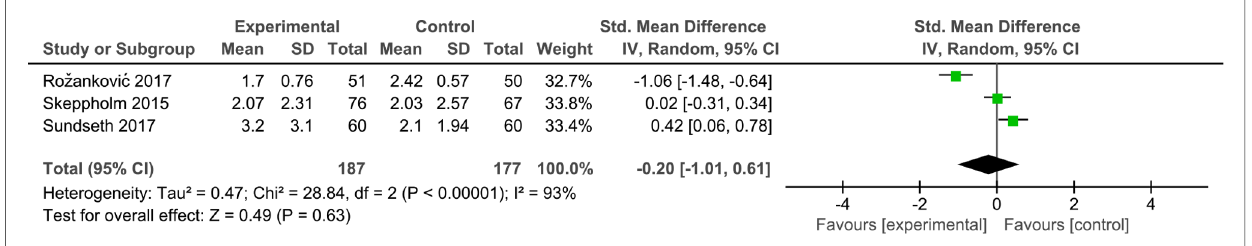
FIGURE 5 Comparison of VAS ARM score between the discover cervical disc arthroplasty (DCDA, “ experimental ” ) group and the anterior cervical discectomy and fusion (ACDF, “ control ” )